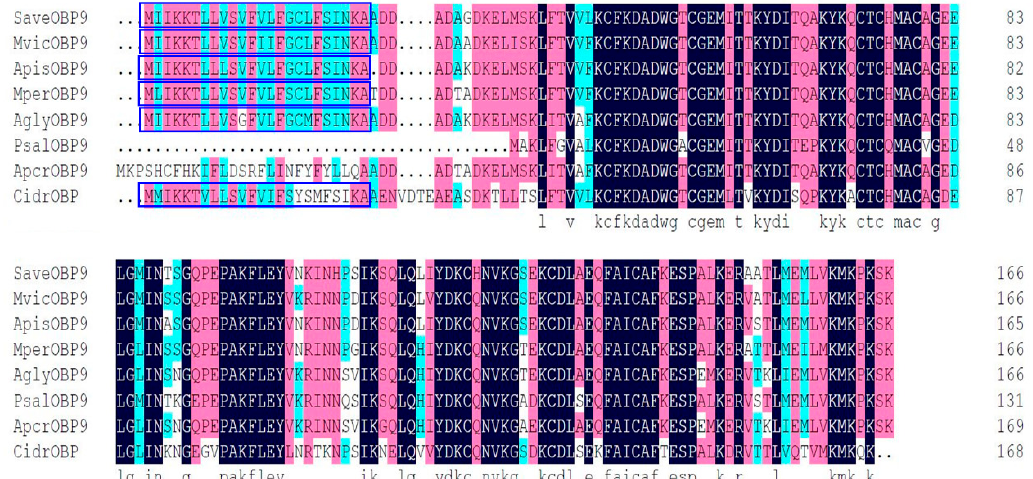
Figure 1. Alignment of SaveOBP9 to OBP genes from various hemipteran insect species. The putative signal peptides are highlighted under blue boxes. The identical residues are highlighted with sea green, pink, and black colors, represents the 80%, 90% and 100% similarities respectively. The other insect species are: Megoura viciae (Mvic), Acyrthosiphon pisum (Apis), Myzus persicae (Mper), Aphis glycines (Agly), Pterocomma salicis (Psal), Aphis craccivora (Apcr), and Cinara cedri (cidr). Gene Bank accession number for all odorant-binding proteins (OBPs) genes are: MvicOBP9 AXE72026.1; ApisOBP9, NP_001153535.1; MperOBP9; AglyOBP9, AHJ80895.1; PsalOBP9, CAR85663.1; ApcrOBP9, KAF0764719.1; and CidrOBP, VVC45546.1.